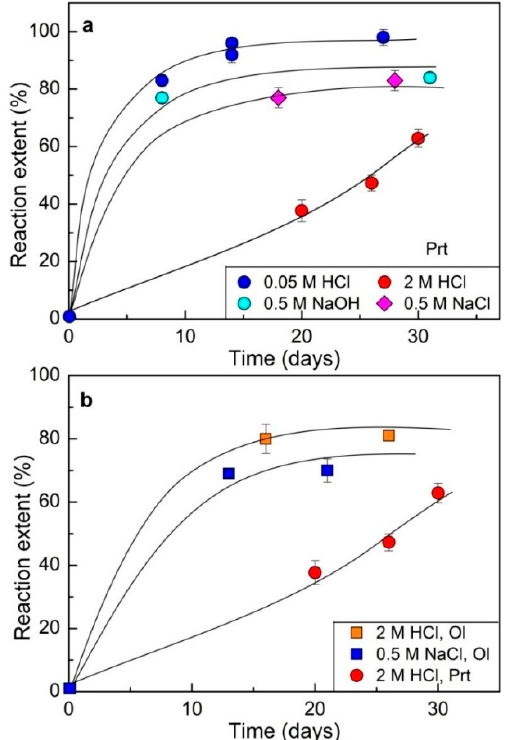
Figure 4. The extent of reaction (%) as a function of time (days): ( a ) shows the influence of pH on the kinetics of peridotite serpentinization; ( b ) illustrates that highly acidic solutions (2 M HCl) accelerate the rates of olivine serpentinization, and they greatly impede the hydrothermal alteration of peridotite.